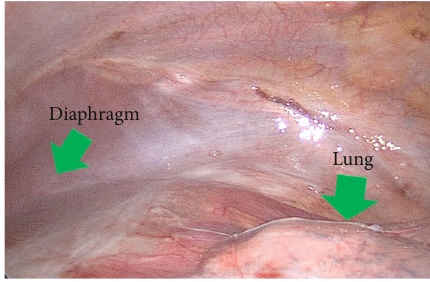
Figure 2: A diagnostic thoracoscopy showed no abnormal fi ndings.